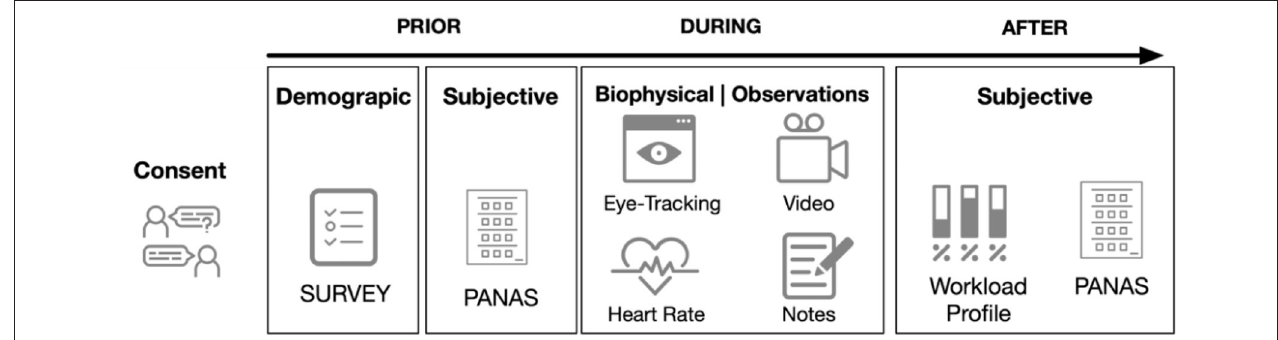
FIGURE 2 | The typical procedure for one session of the study prior, during and after the recording.